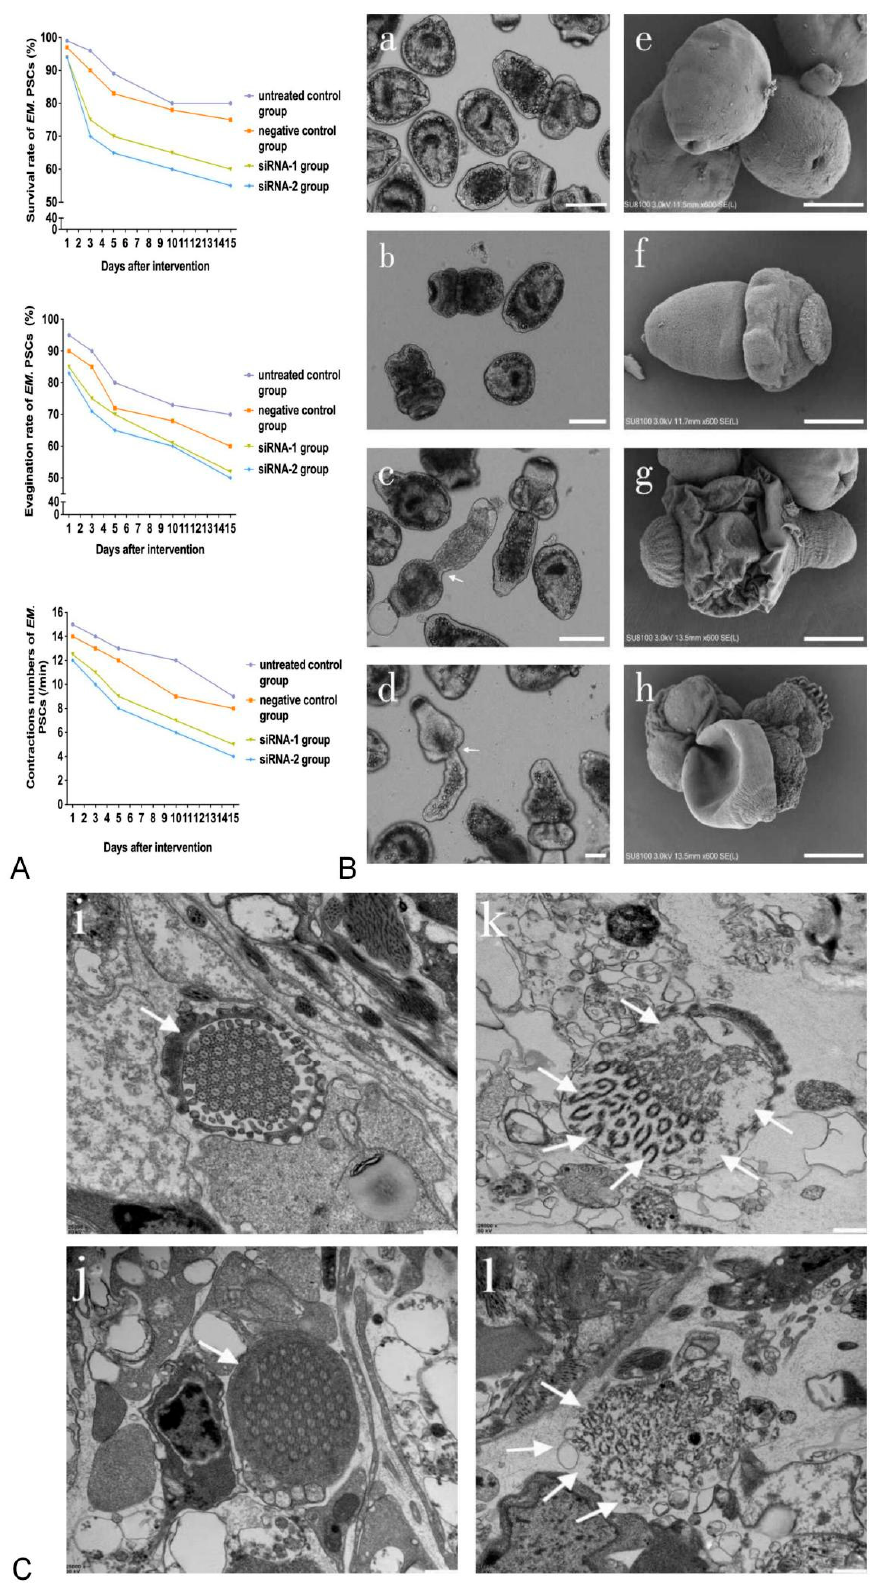
Figure 2. Biological changes in E. multilocularis PSCs treated with siRNA-1 and siRNA-2. ( A ) Bio- logical changes in E. multilocularis PSCs treated with siRNA-1 and siRNA-2 at different time points. ( B ) Biological changes in E. multilocularis PSCs on day 15. Images a–d show the appearance of